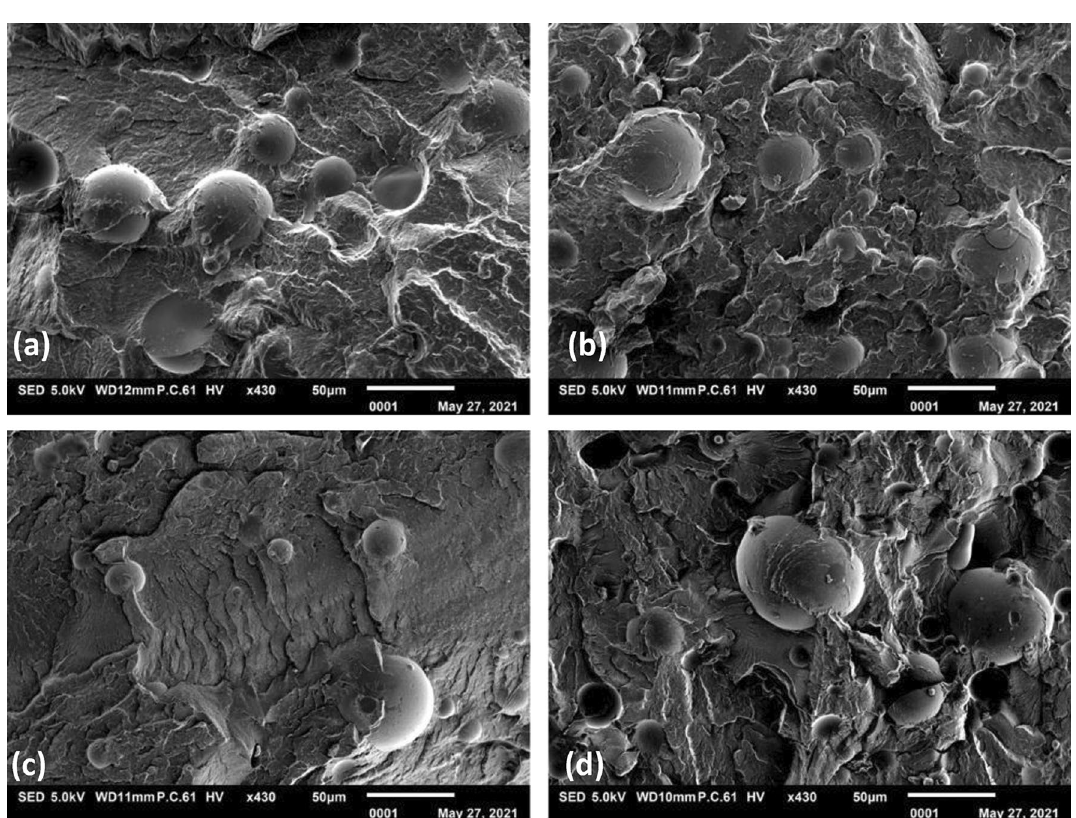
Figure 5. Fracture surface of composites: ( a ) PA66/GB16, ( b ) PA66/GB23, ( c ) PBT/GB12 and ( d )